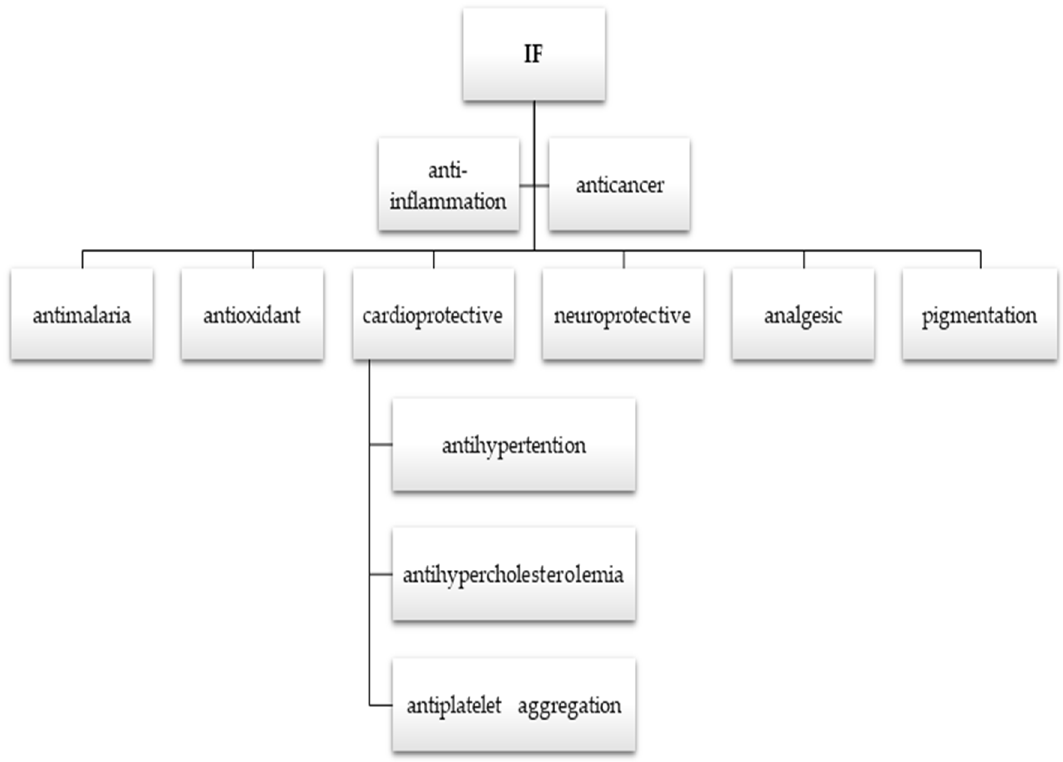
ff ects of IF. IF: